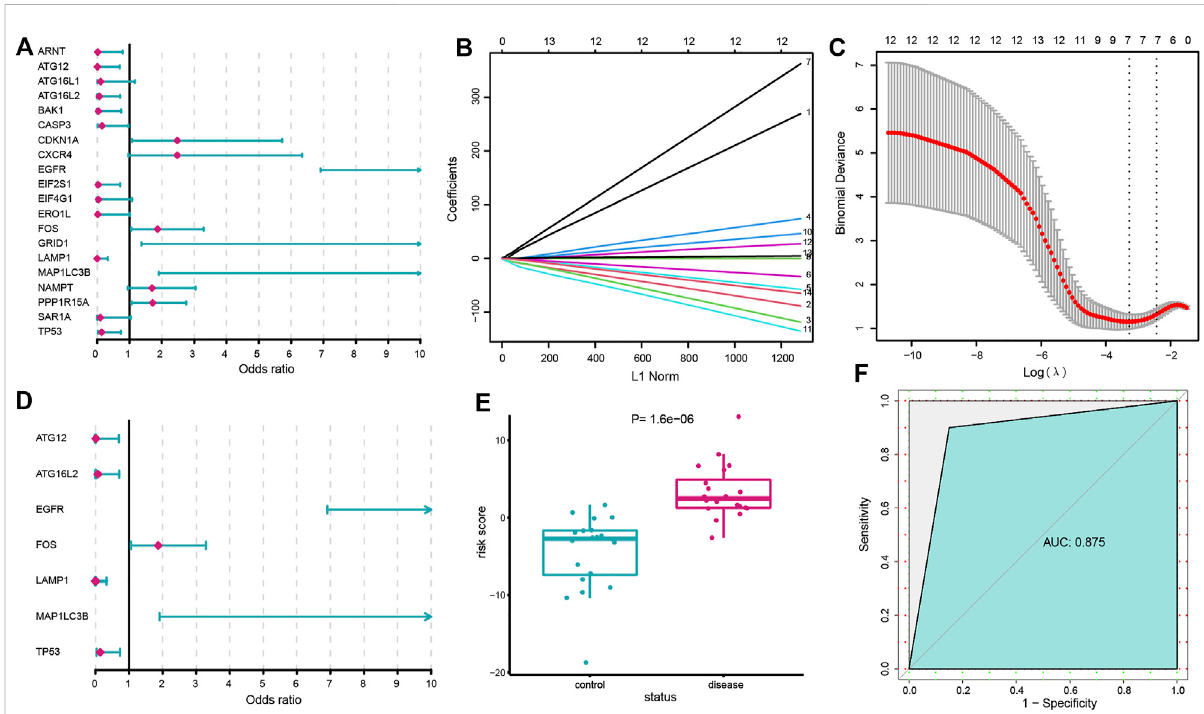
FIGURE 2 Construction of the autophagy-related classi fi er. (A) Relationships between 20 dysregulated autophagy genes and IS using univariate logistic regression analysis. (B) Least absolute shrinkage and selection operator (LASSO) coef fi cient pro fi les of dysregulated autophagy genes ( p < 0.05). (C) 10-fold cross-validation for tuning parameter selection in the LASSO regression. The partial likelihood deviance is plotted against log ( λ ), where λ is the tuning parameter. Partial likelihood deviance values are shown, with error bars representing SE. The dotted vertical lines are drawn at the optimal values by minimum criteria and 1-SE criteria. (D) Multivariate logistic regression developed a classi fi er consisting of seven autophagy genes. (E) Risk distribution between IS and healthy subjects, where IS has a much higher risk score than healthy samples. (F) ROC curve evaluated the discrimination ability of the classi fi er